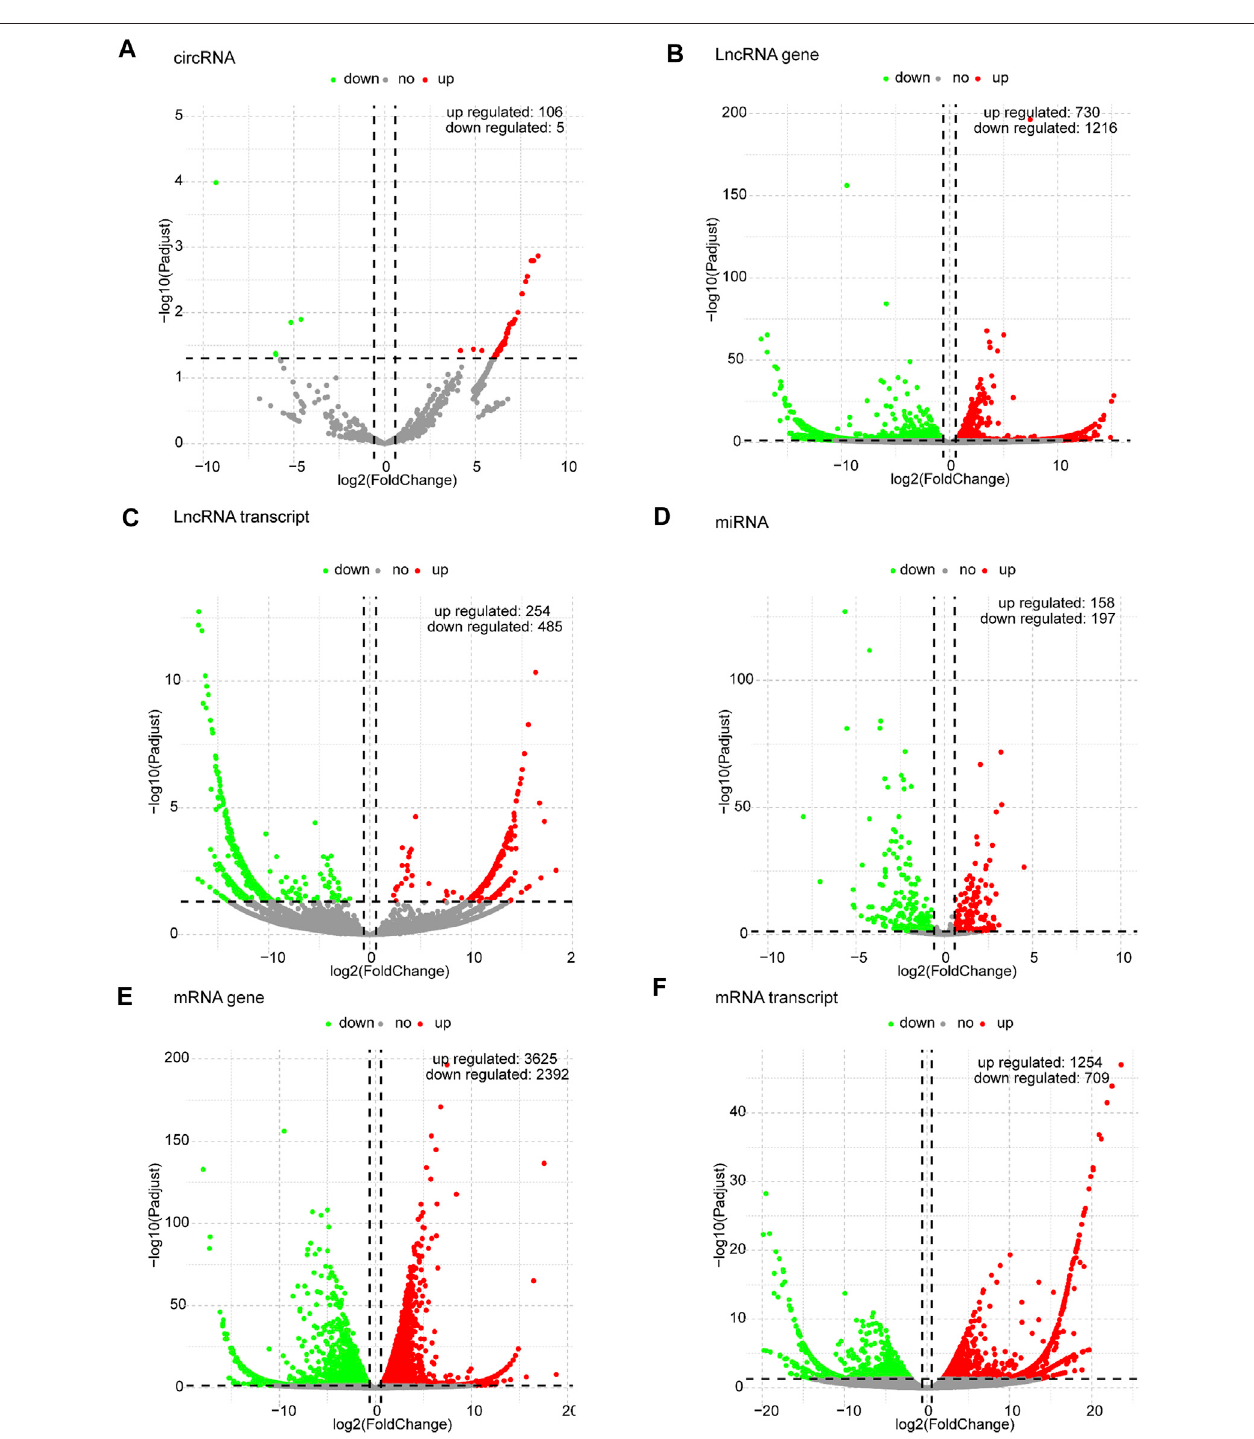
FIGURE4| VolcanoplotsofdifferentiallyexpressedRNAsinx90astrocytes. (A) circRNA, (B) lncRNAgenelevel, (C) lncRNAtranscriptlevel, (D) miRNA, (E) mRNA gene level, and (F) mRNA transcript level in astrocytes cultured for 90 days in vitro. Red and green indicate up and downregulation, respectively.